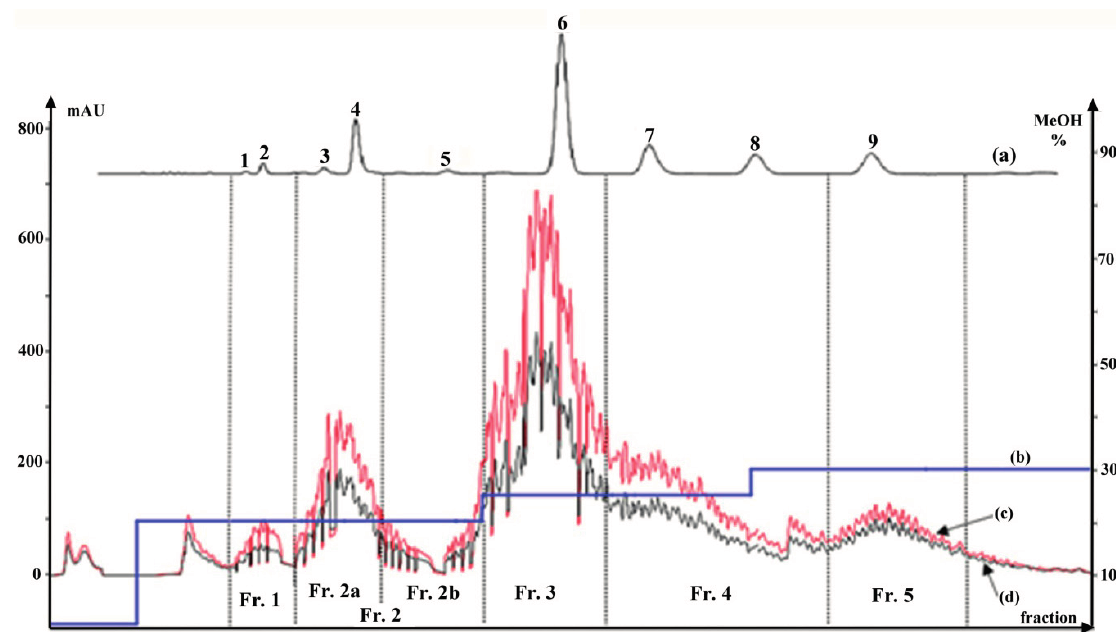
Figure 2. HPLC chromatogram of a crude extract from Pueraria lobata (a); gradient elution curve from FC (b); FC chromatogram of crude extract at 250 nm (c) and at 270 nm (d); Compounds 1 – 9 ; Fractions 1–5. (Fr.,